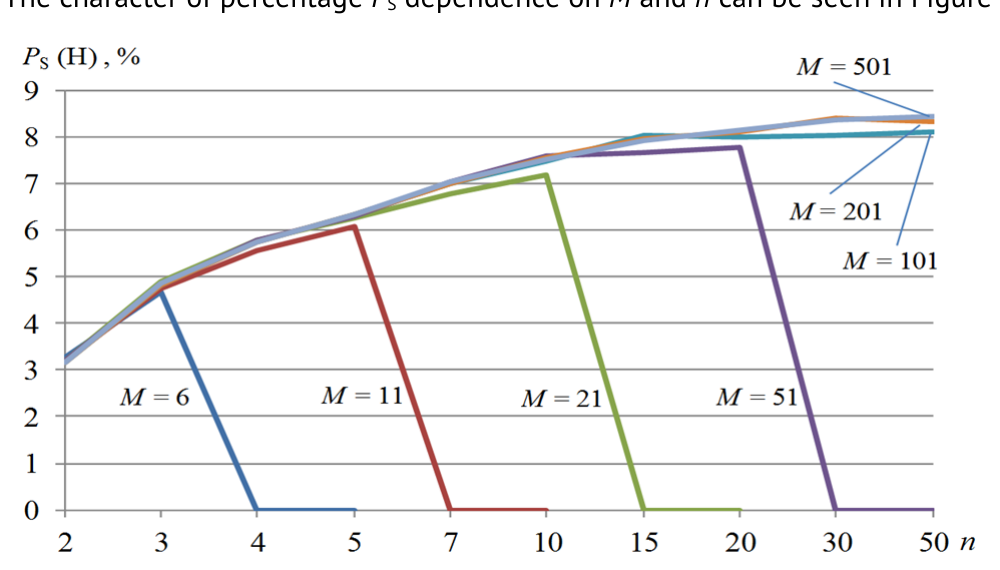
Figure 4. Parameter P dependence to M and n for Hamilton S